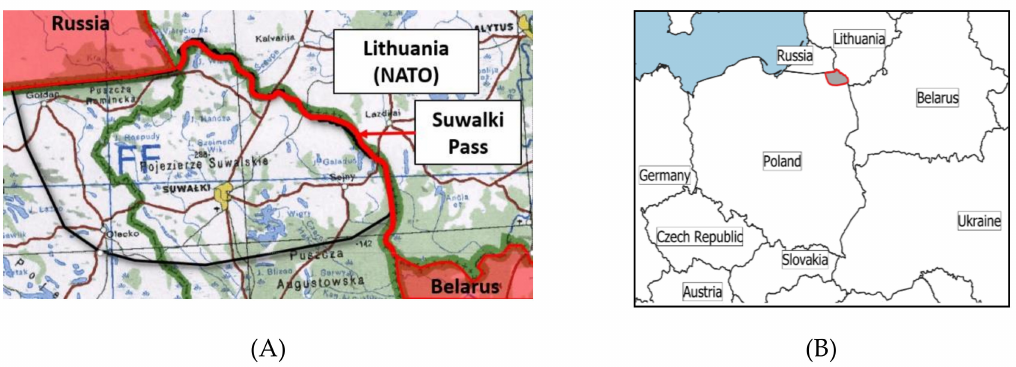
Figure 1. Tested research area. ( A )—course of the Suwalki Pass, ( B) —location of the test area on the territory of Poland and neighboring countries.